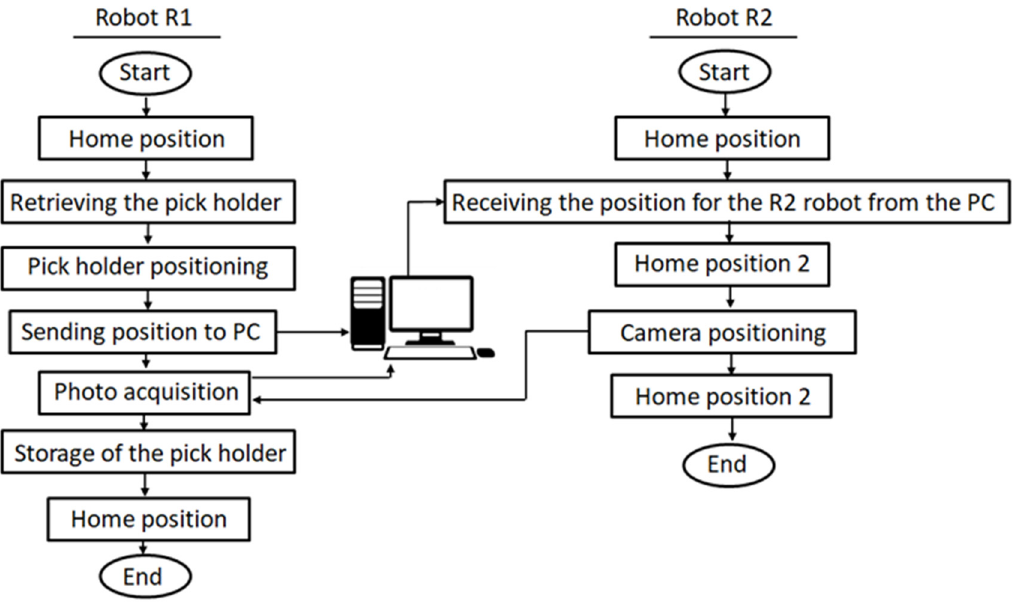
Table 1. KUKA MXG20 camera and Tamron M118FM25 lens specifications.